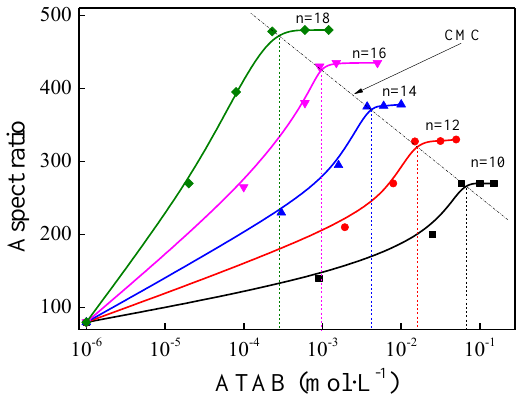
Figure 7. Influence of alkyl trimethyl ammonium bromides (C n H 2n+1 (CH 3 ) 3 NBr, ATABs) on the aspect ratios of α-CaSO 4 ·0.5H 2 O whiskers.